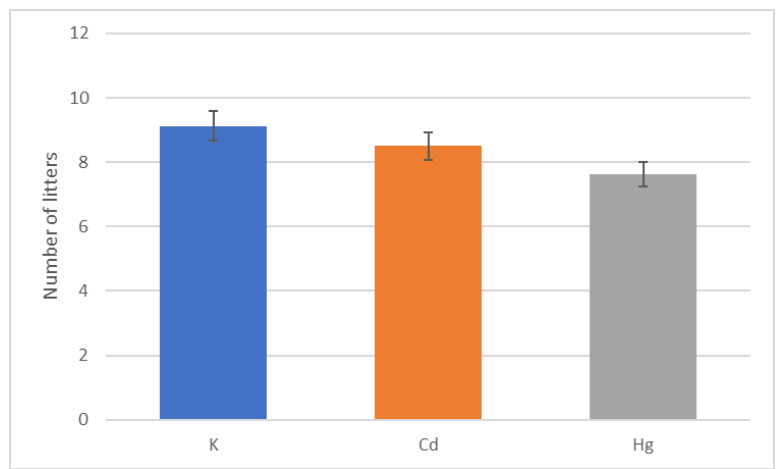
Figure 4. A comparison of litters. n = 8 per group.